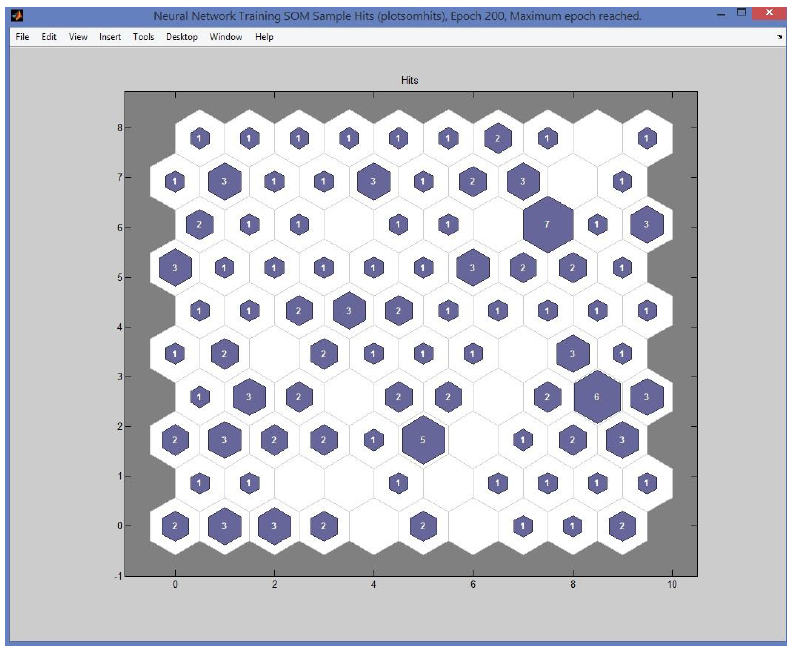
Figure 11. SOM sample hit plot using the GUI toolbox in MATLAB.